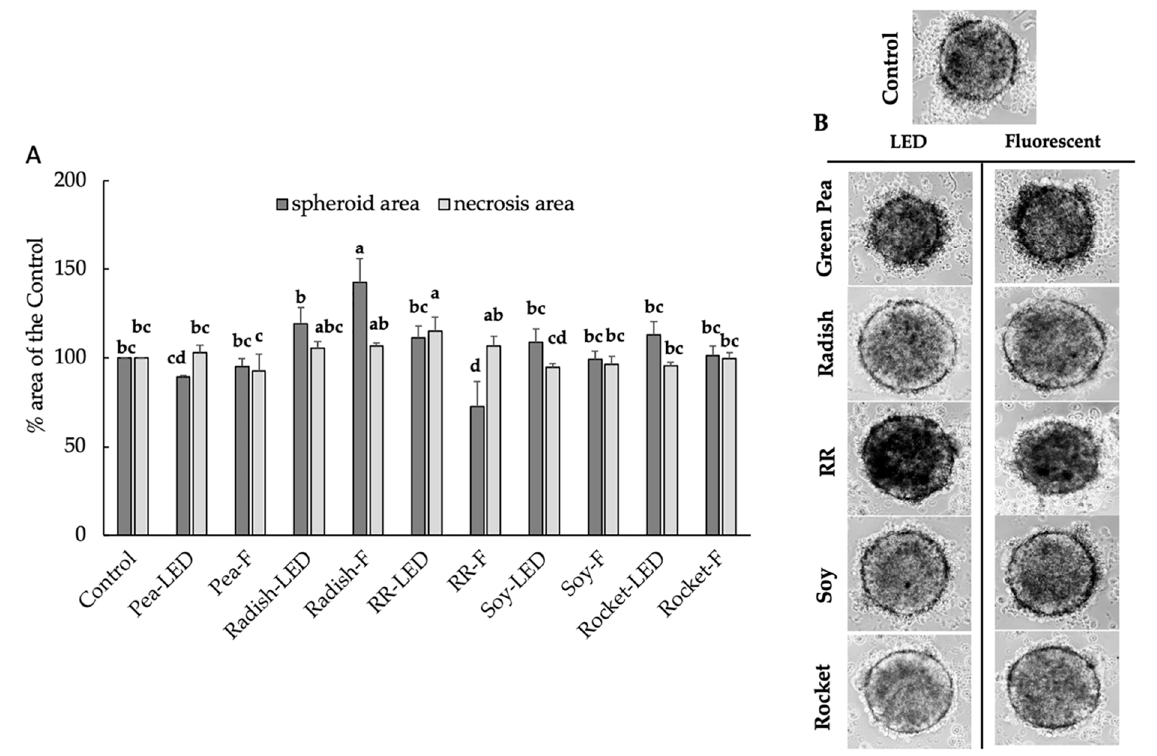
Figure 5. The anti-proliferative (spheroid area) and pro-apoptotic effects (necrosis area) ( A ) on RD-ES exposed for 120 h to 20 μ L green pea, radish, Red Rambo (RR), soybean (soy), and rocket microgreens, cultivated under LED and fluorescent (F) lighting. Values are the mean ± SD of six replicates ( n = 6). The different lowercase letters (a–d) represent significant differences for the microgreen species under different lighting for spheroid area and necrosis area, respectively ( p < 0.05), as determined from a one-way ANOVA. Associated images showing pro-apoptotic effects (necrosis area) of RD-ES are shown ( B ).